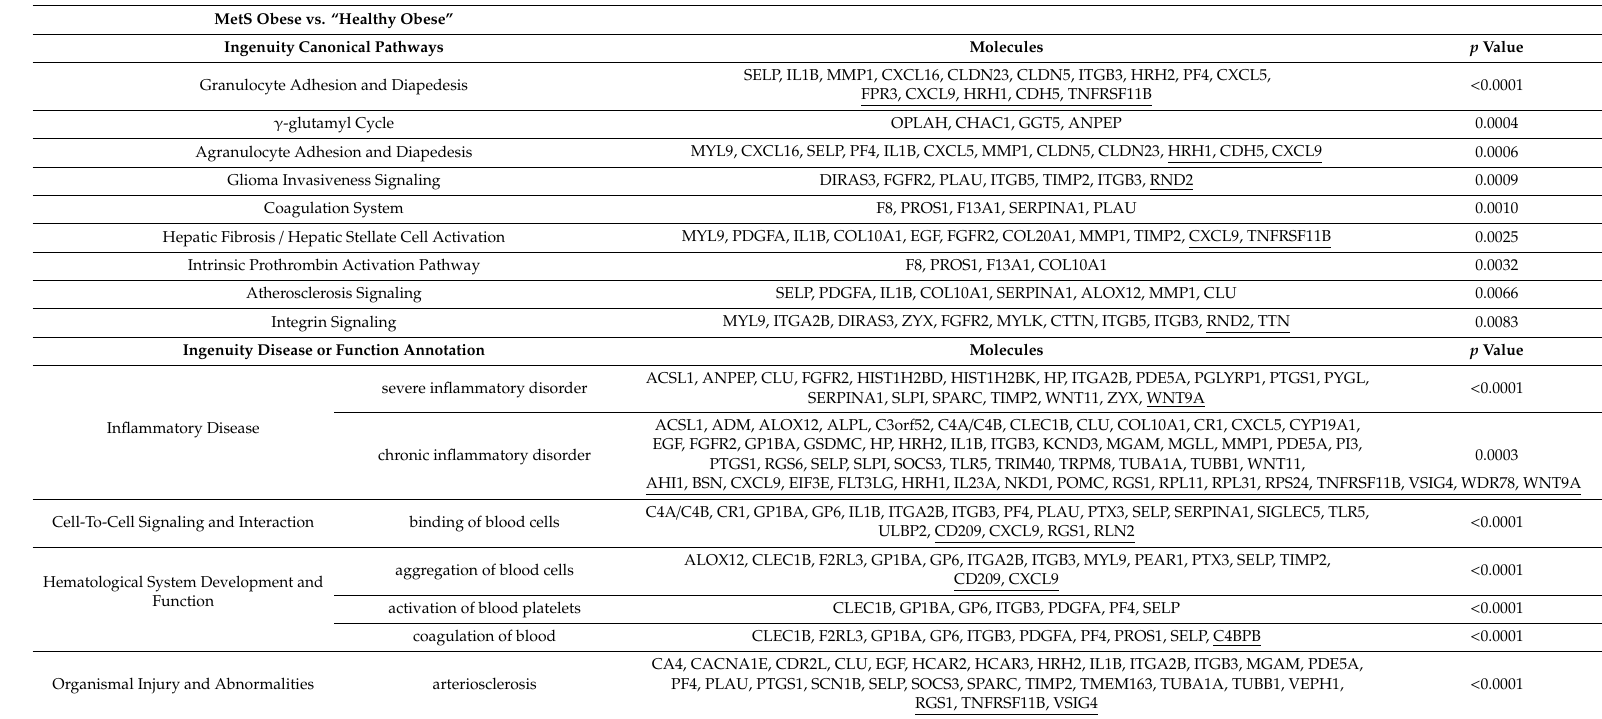
Table 3. Enrichment in Ingenuity Canonical Pathways and Diseases or Functions Annotations among genes di ff erentially expressed between MetS obese and “healthy obese” individuals, where the majority of genes within each pathway are up-regulated. Down-regulated genes are